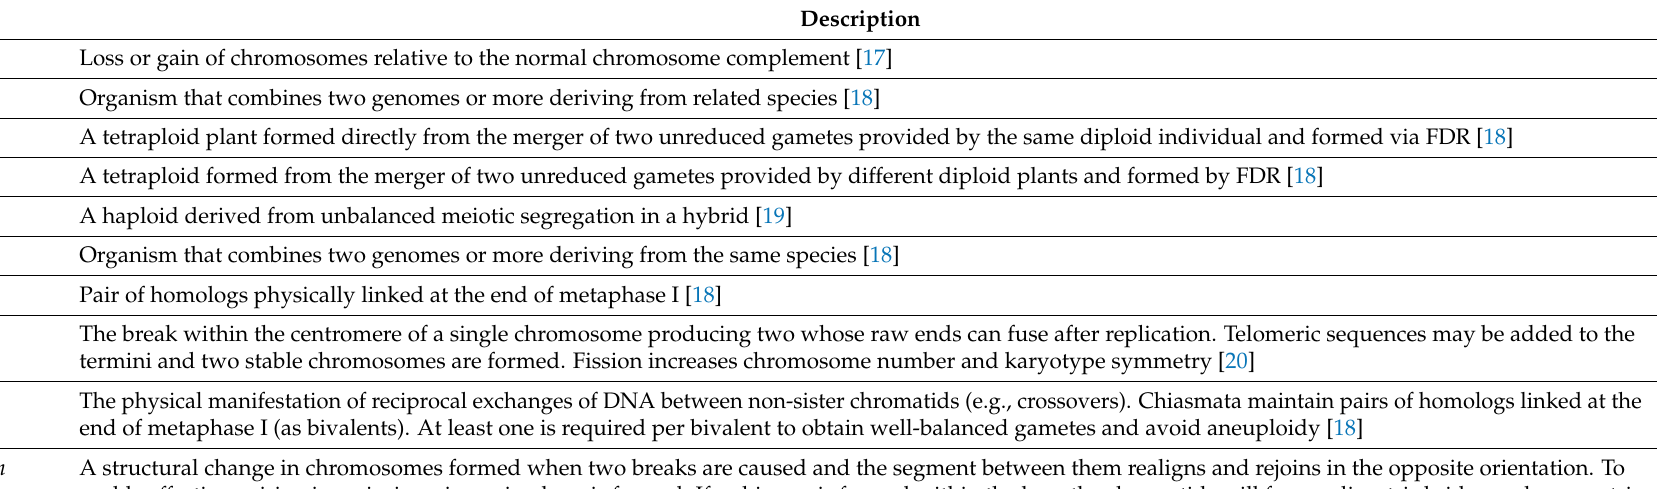
Table 1. Processes involved in meiotic polyploidization and karyotype evolution in orchids and plants in